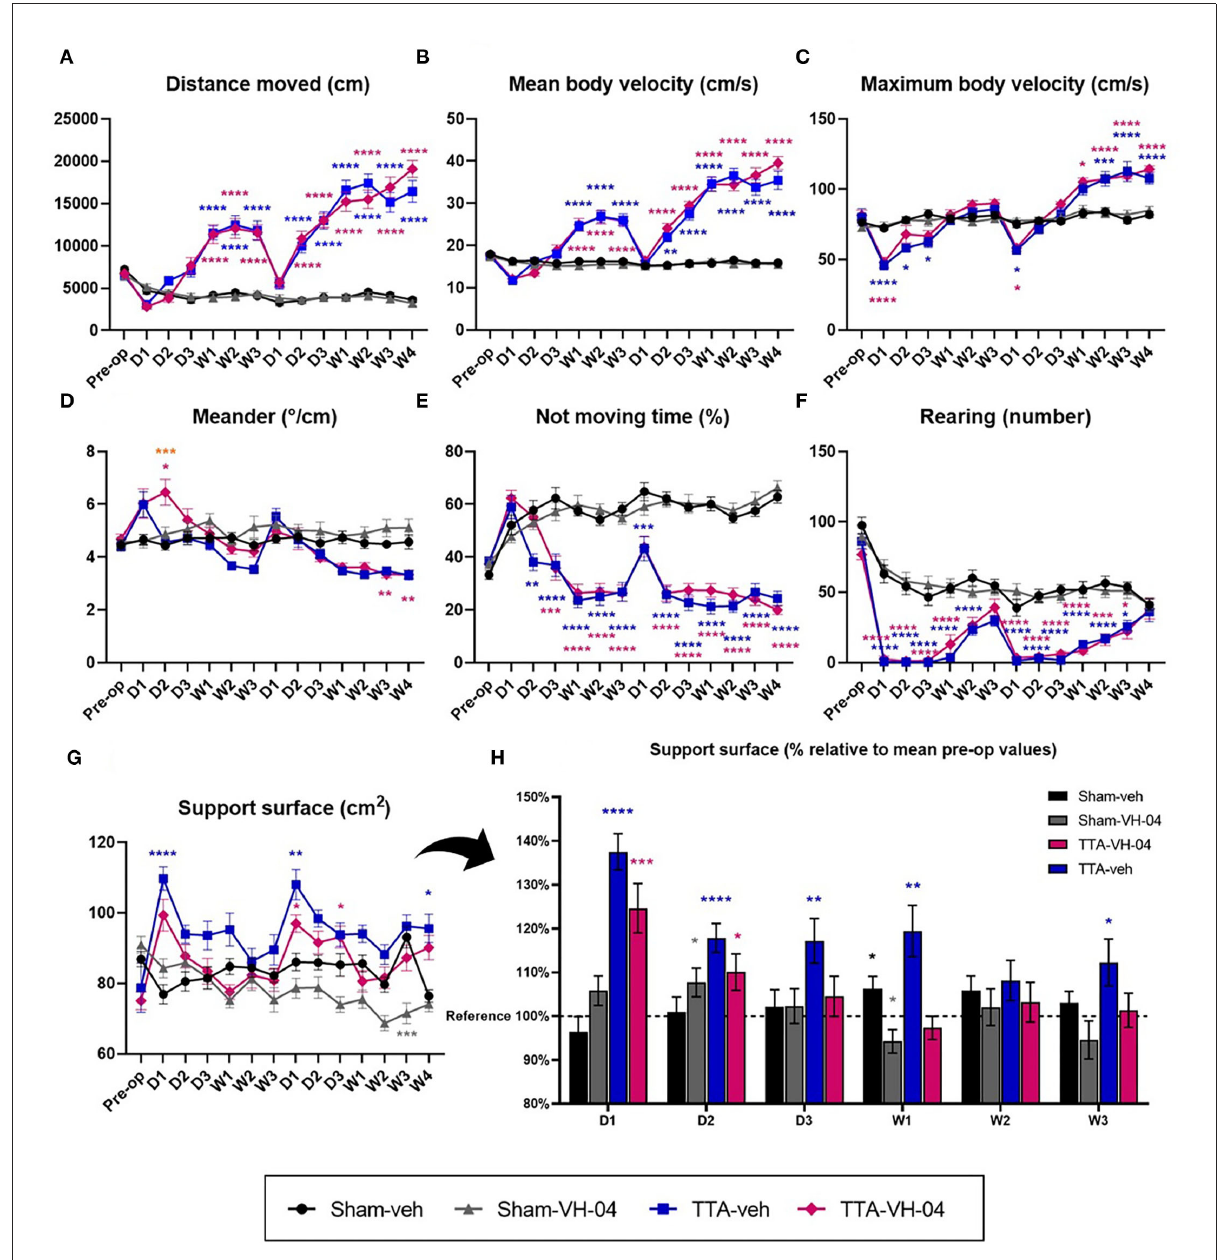
FIGURE3 Illustration of the average distance moved (A) , mean body velocity (B) , maximum body velocity (C) , meander (D) , not moving time (E) , and number of rearing (F) automatically measured in a 10 min-session in an open field. Illustration of the support surface area in cm 2 (G) and in % relative to mean pre-op values (H) . Data represent mean ± SEM. Three-way ANOVA applies to graphs (A–G) and one sample t-test applies to graph (H) . (A–G) Significant differences between groups Sham-veh and Sham-VH-04, Sham-veh and TTA-veh, Sham-VH-04 and TTA-VH-04, and TTA-VH-04 and TTA-veh are indicated by gray, blue, purple, and orange stars, respectively. (H) Significant differences with the mean pre-op value of the four groups (referred to as reference) are indicated by black, gray, blue, and purple stars for Sham-veh, Sham-VH-04, TTA-veh, and TTA-VH-04 groups, respectively. * p < 0.05; ** p < 0.01; *** p < 0.001; **** p < 0.0001. Sham-veh and Sham VH-04, n = 16; TTA-veh and TTA-VH-04, n = 15.